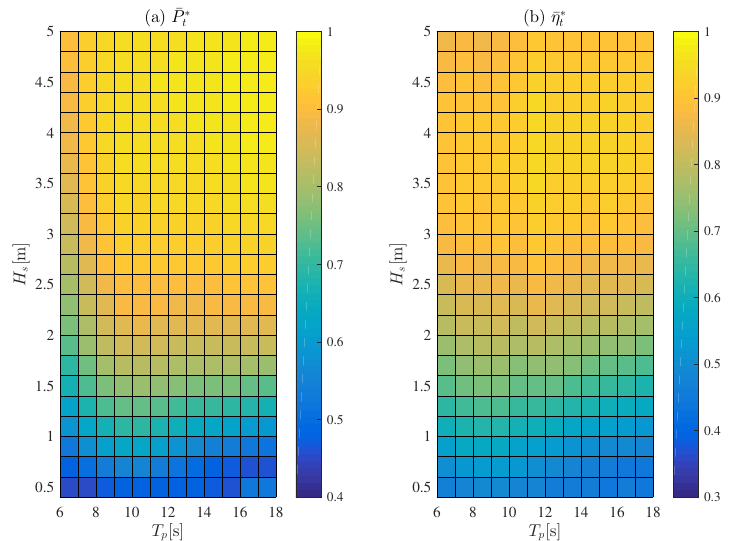
Figure 16. Time averaged results of the CAV controller under the PM irregular wave model with various T p and H s for T m = 5000 s when Ω d = 550 rad/s: ( a ) relative power extraction from turbine; ( b ) relative average turbine